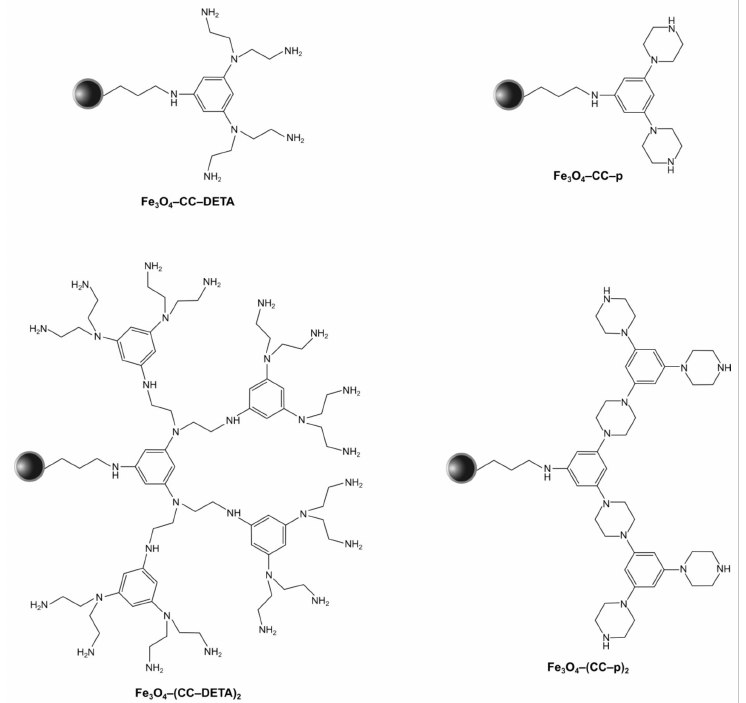
Figure 2. The structures of the obtained the triazine dendrons-modified magnetic